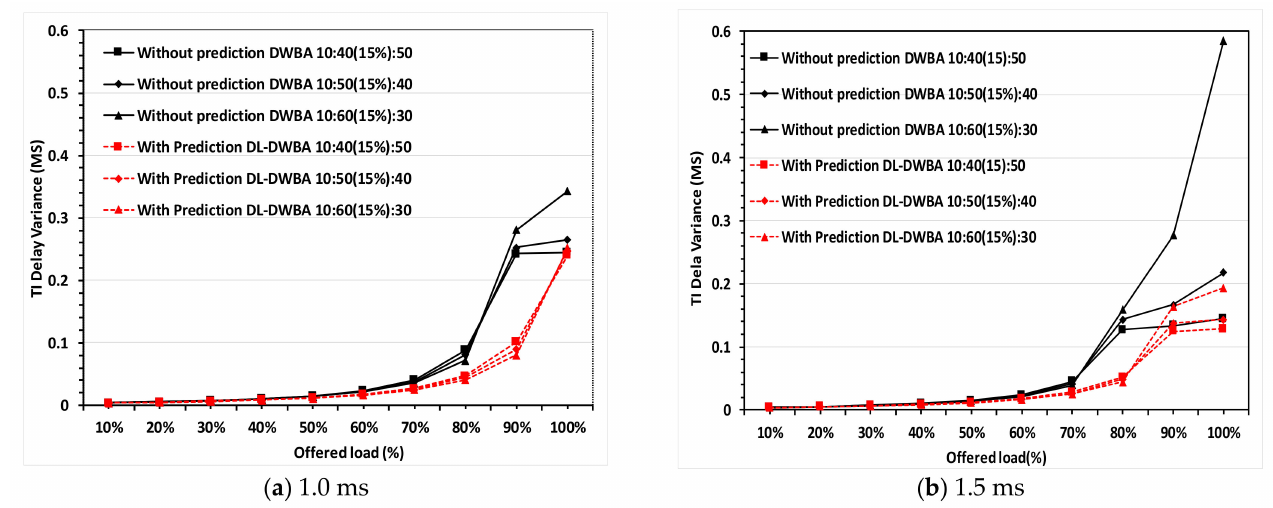
Figure 7. TI Jitter